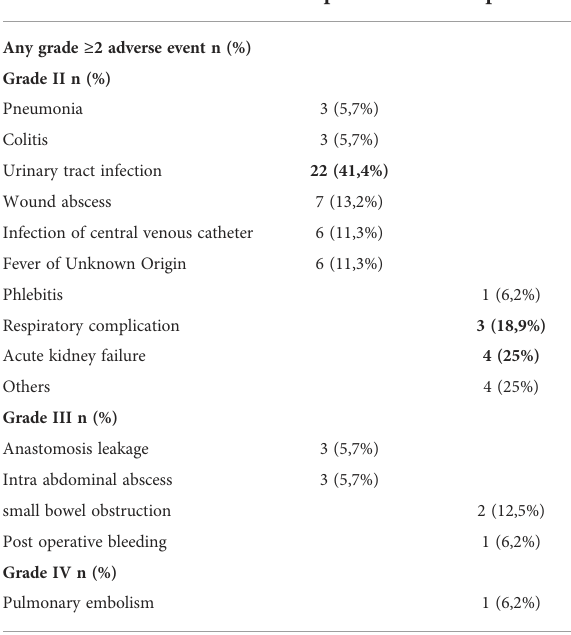
TABLE 2 Postoperative complications according to the Common Terminology Criteria for Adverse Events (CTCAE) Version